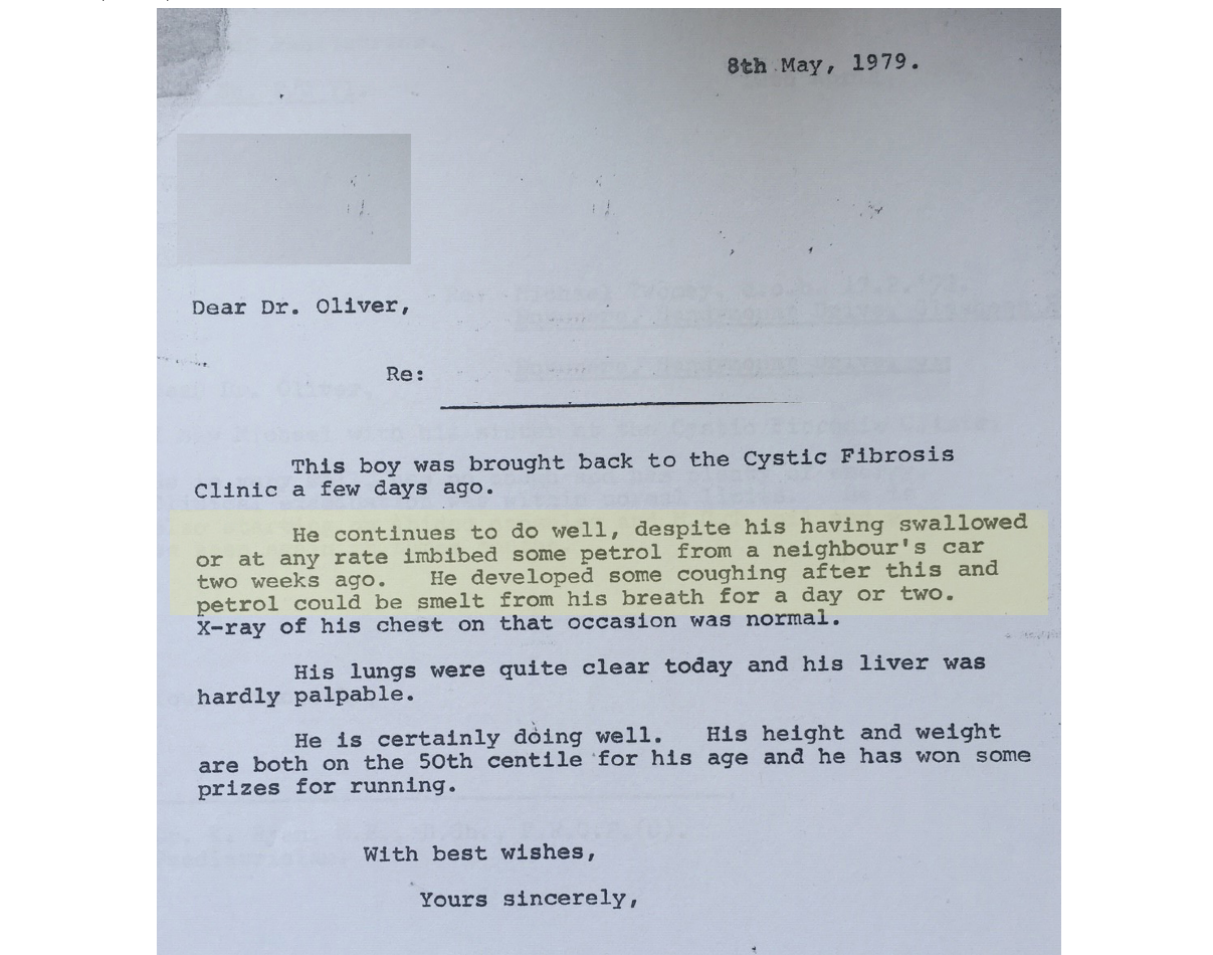
Figure 2. The petrol